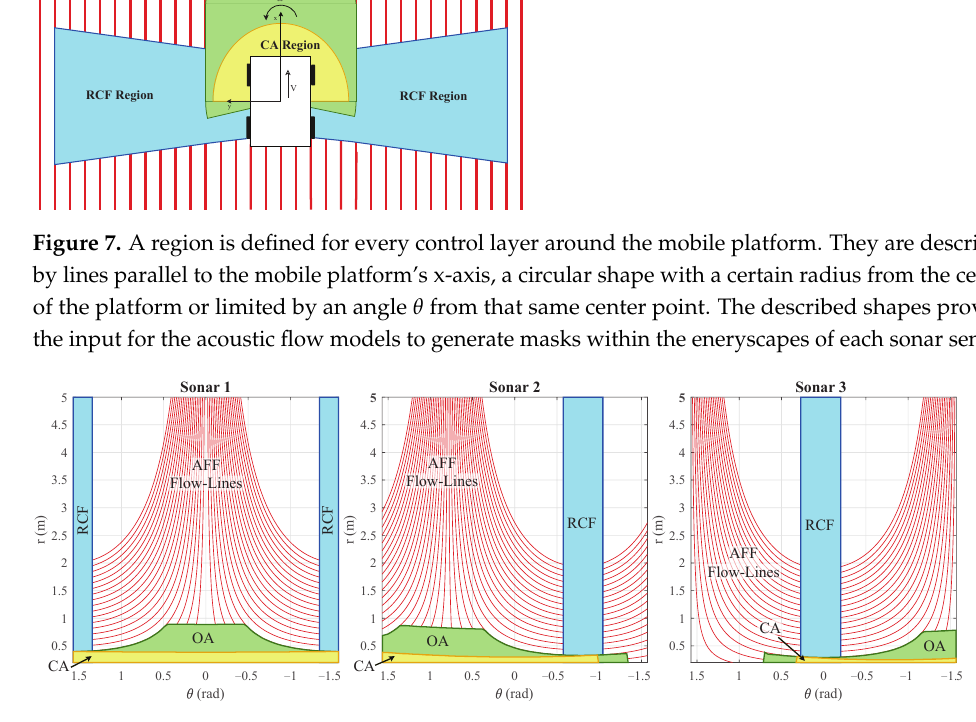
Figure 8. The generated masks for each eRTIS sensor in Figure 4a are drawn for the control zones of Figure 7 for the four different motion behavior